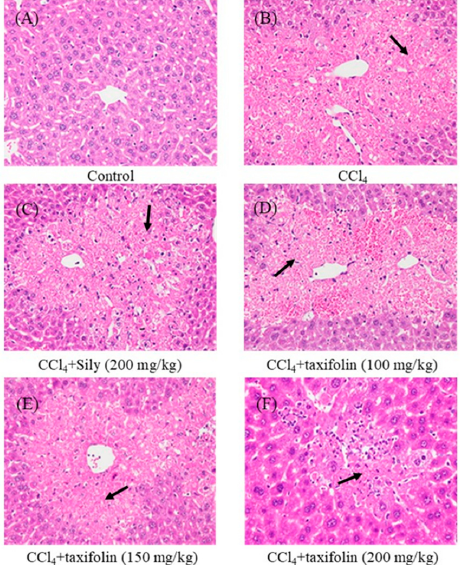
Figure 2. Histopathological changes in mice with acute hepatic injury induced by CCl 4 ; images are presented from control and CCl 4 treated mice with and without Sily and taxifolin pretreatments. Normal glycogen infiltration in a mouse of the control group ( A ); in liver sections from mice treated with CCl 4 , hematoxylin and eosin (H&E) staining showed hepatocellular vacuolization and moderate hepatic necrosis in portal areas ( B ). Sily ( C ) 100 mg / kg taxifolin ( D ), 150 mg / kg taxifolin ( E ), and 200 mg / kg Table 1. Quantitative summary of the protective e ff ects of Sily and taxifolin on hepatic damage induced by CCl 4 based on histopathological observations.